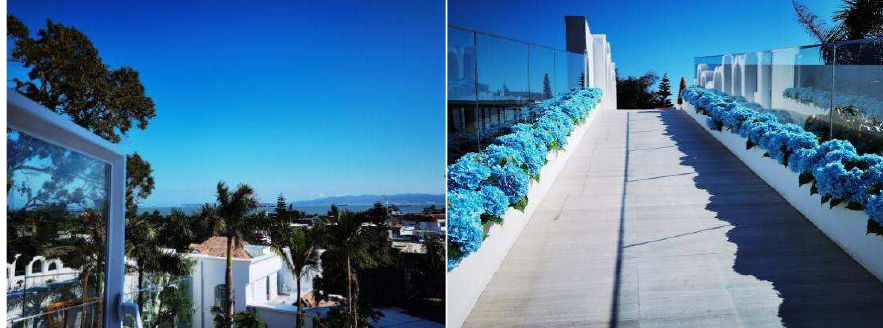
Land 2022 , 11 , x FOR PEER REVIEW Figure 6. High-quality hotels and outdoor spaces. Source: Taken by the authors. Figure 6. High-quality hotels and outdoor spaces. Source: Taken by the authors. Figure 6. High-quality hotels and outdoor spaces. Source: Taken by the authors.